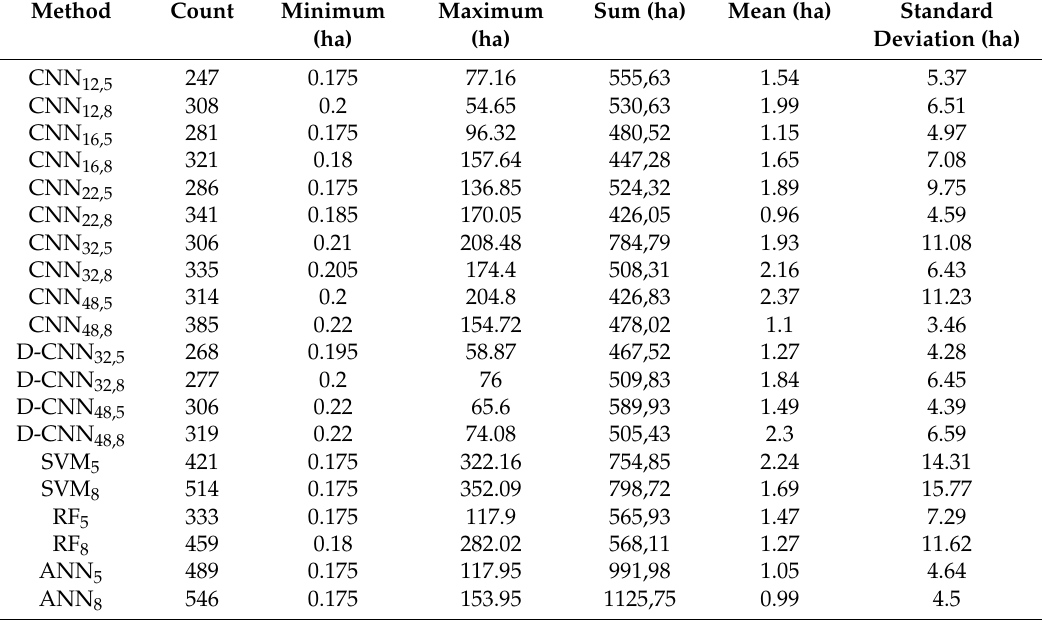
Table 2. Statistical analysis of the landslide detection results. The count of the extracted polygons as landslide areas, the minimum and maximum sizes of the landslide areas, total detected areas, mean and standard deviation